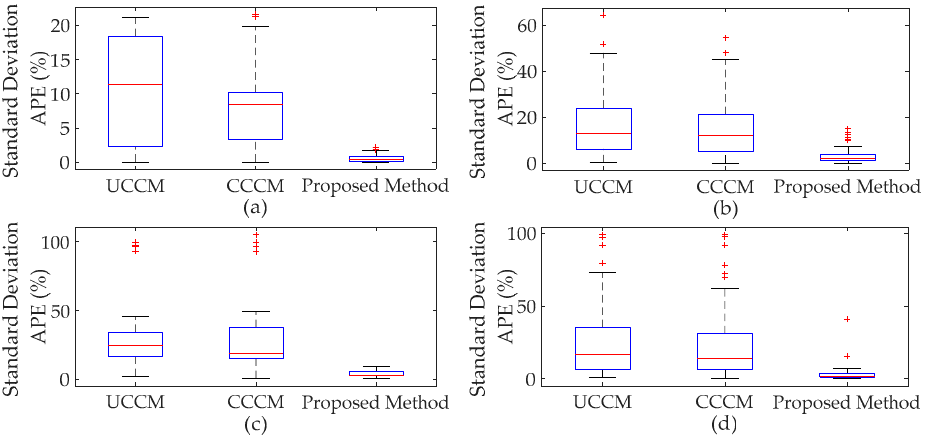
Figure 8. Box plot of standard deviation APE of results (modified IEEE 118-bus test system). ( a ) Voltage angle; ( b ) Voltage magnitude; ( c ) Active power generation; ( d ) Reactive power generation.